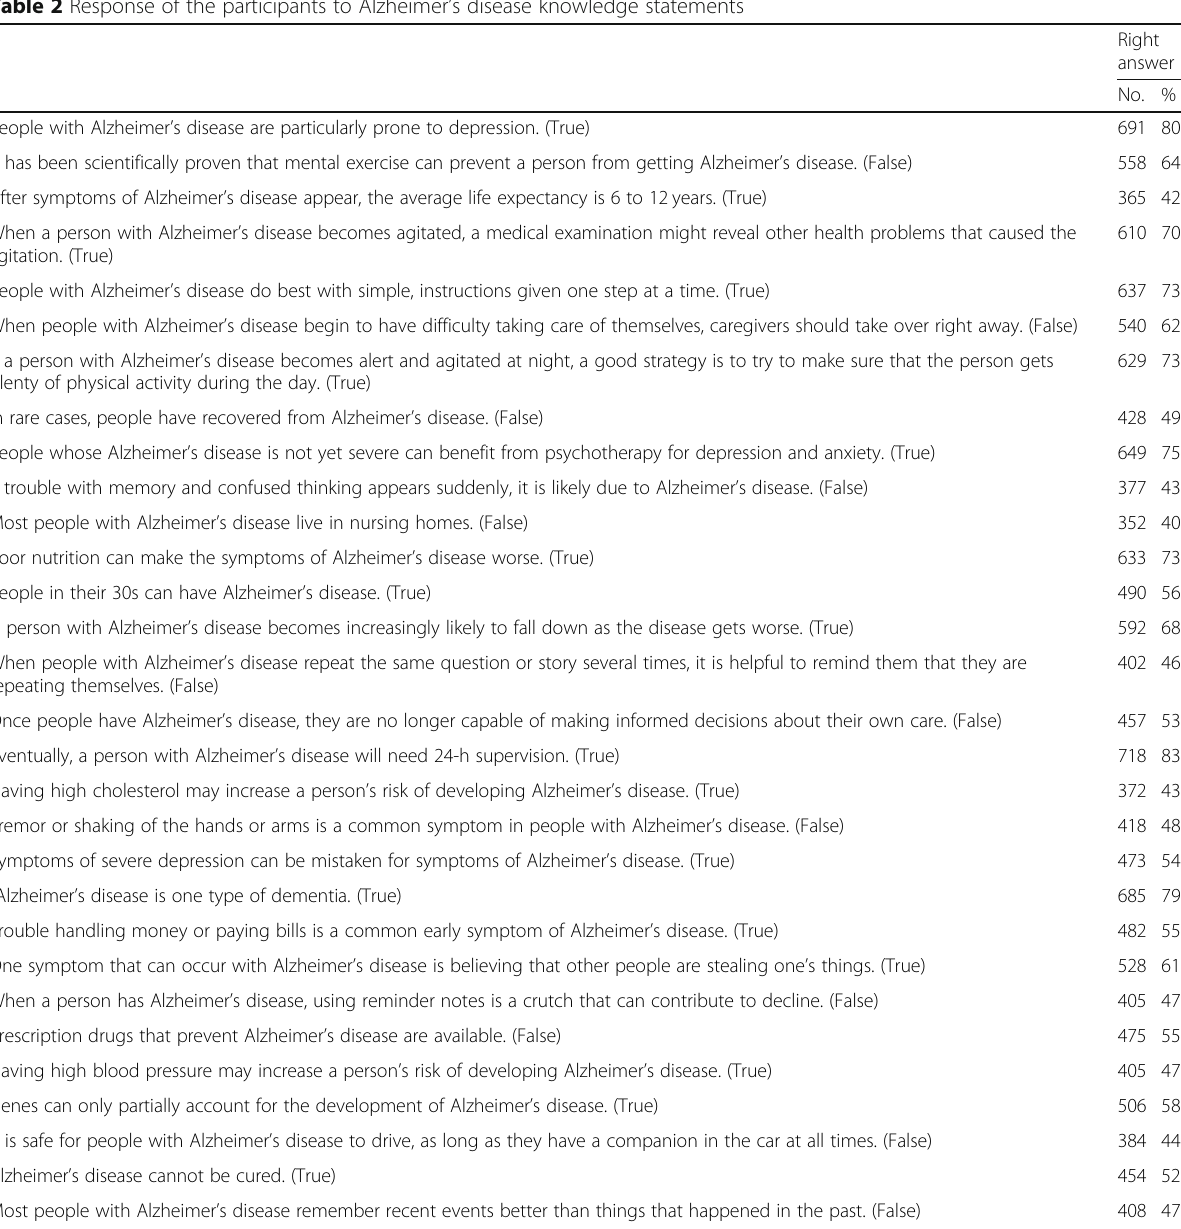
Table 2 Response of the participants to Alzheimer ’ s disease knowledge statements